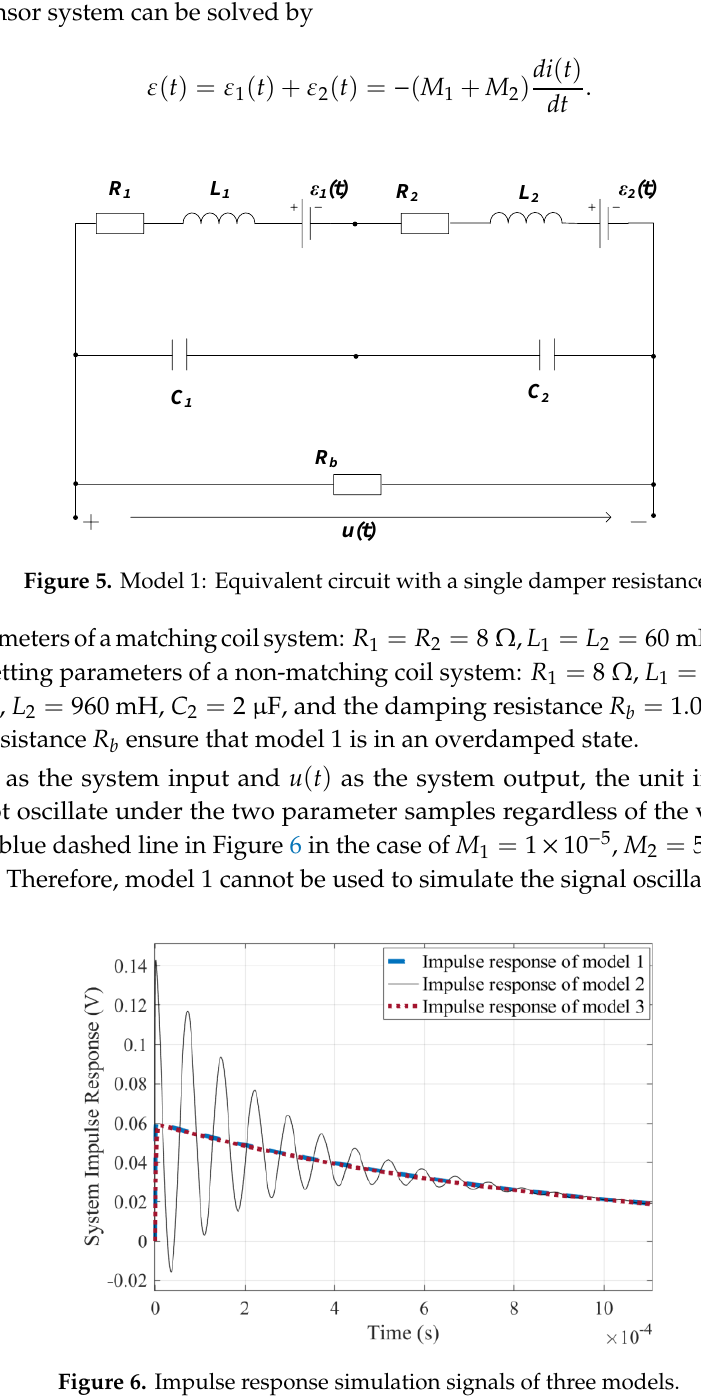
Figure 6. Impulse response simulation signals of three models.